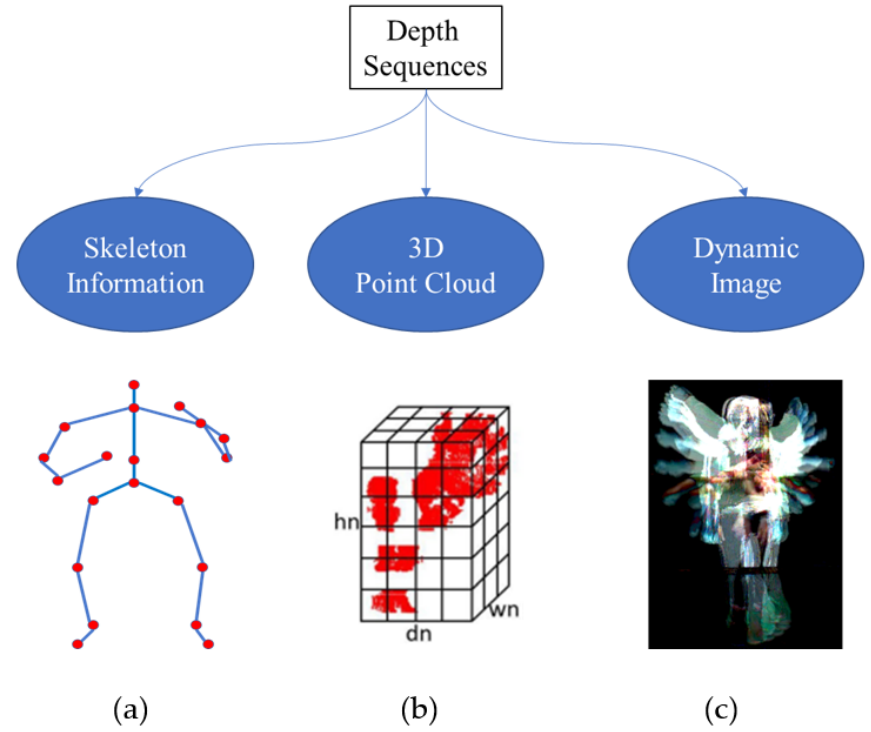
Figure 1. Different techniques to encode the depth sequence into a spatio-temporal image; ( a ) skeleton, ( b ) point cloud, and ( c ) dynamic image from depth sequence.